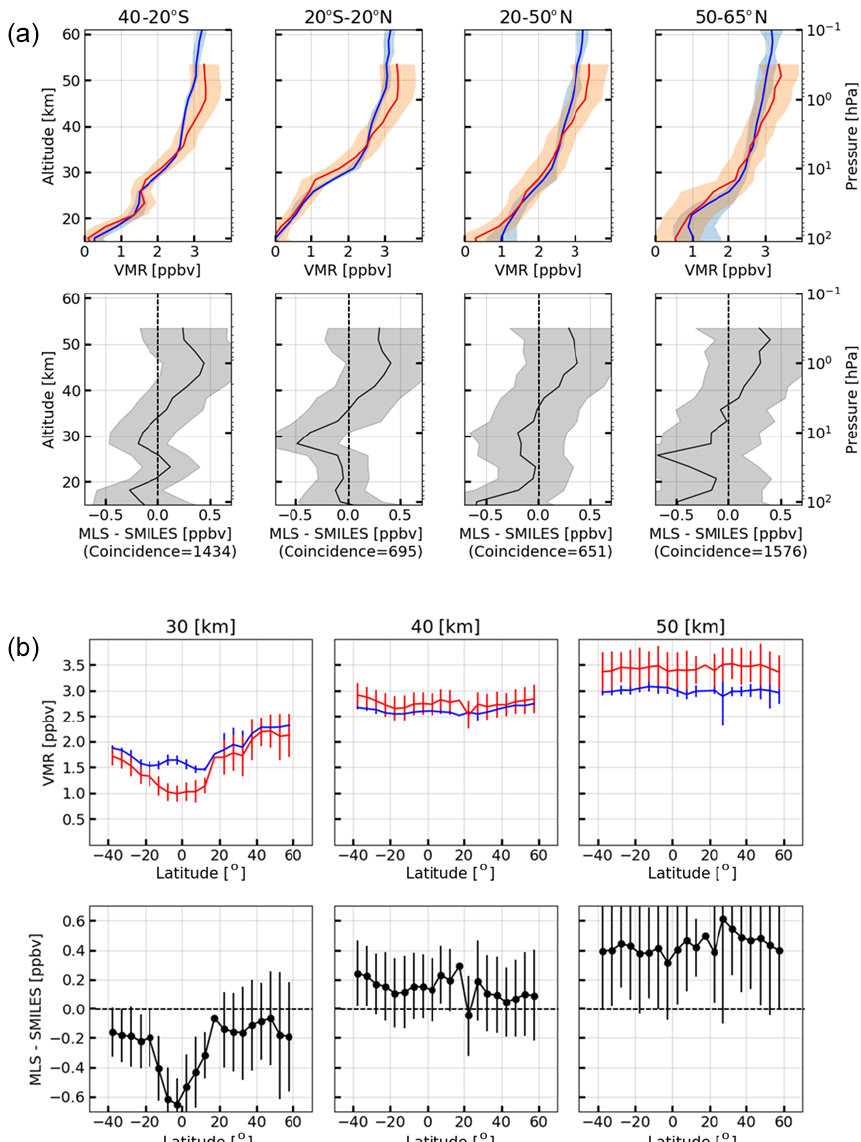
Figure 7. (a) Mean HCl profiles, 1 σ uncertainty based on variability (shaded region) and the absolute differences for each latitude region. Upper row: the blue and red lines indicate the mean profiles from SMILES and MLS for 40–20 ◦ S, 20 ◦ S–20 ◦ N, 20–50 ◦ N, and 50–65 ◦ N (left to right panels). Lower row: the absolute difference between the SMILES and MLS profiles calculated using Eq. (3) for each latitude region. (b) Latitudinal variation of SMILES and Aura/MLS HCl profiles at three altitude levels. The profiles were averaged for each 5 ◦ bin. Upper row: mean of SMILES (blue) and MLS (red) profiles for each altitude level. The error bars indicate 1 σ uncertainties. Lower row: the means and 1 σ of the absolute differences are